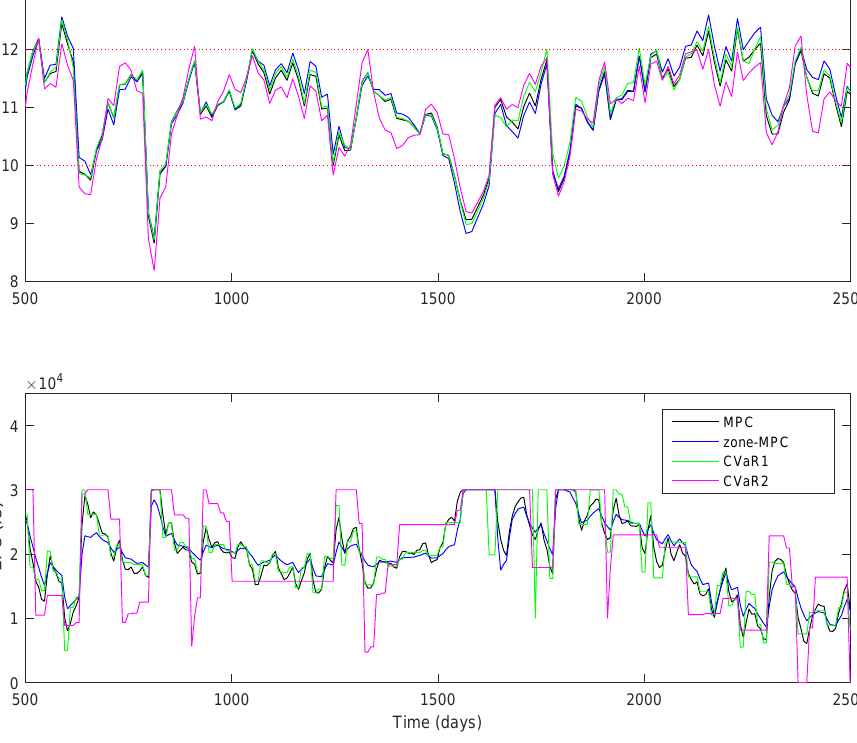
Figure 11. Results under Gaussian process